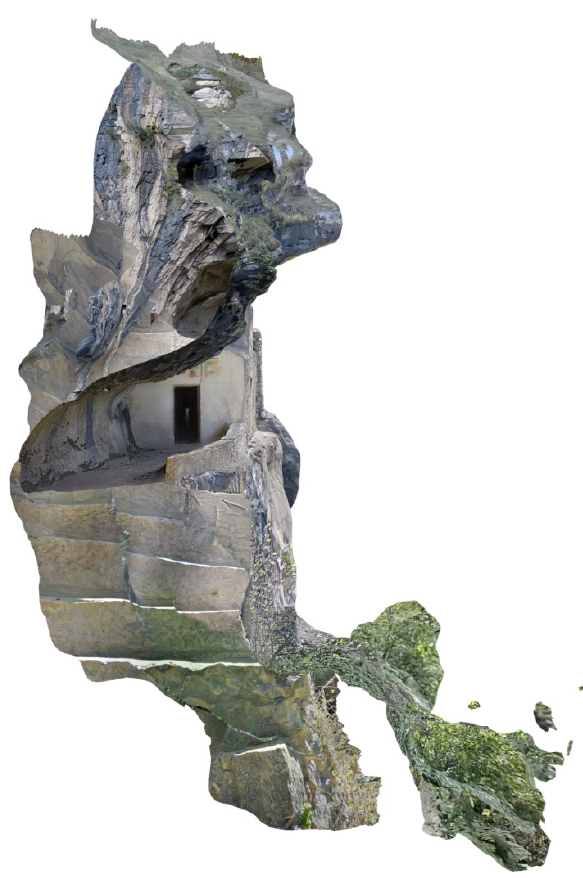
Figure 21. Complete polygonal 3d model, textured and with new geometric